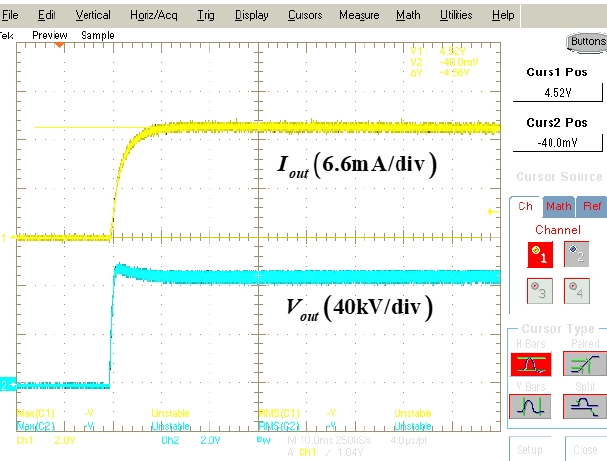
Figure 10. Feedback voltage for predicting the output voltage and output current.